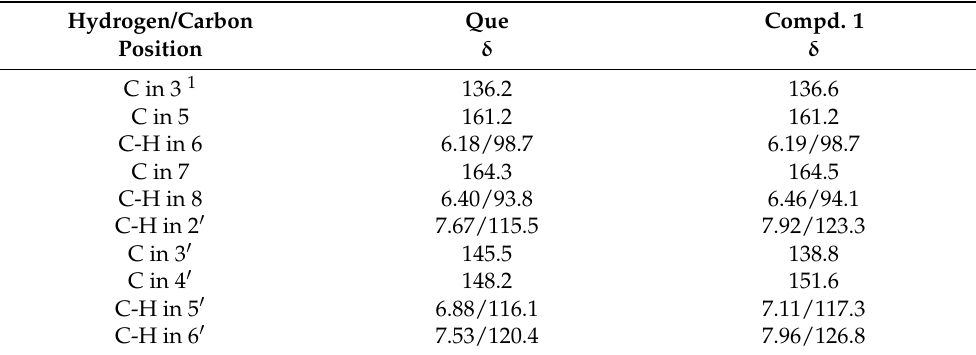
Table 1. 1 H- and 13 C-NMR (600 MHz, DMSO- d 6 ) chemical shifts of the protons and carbons of quer- cetin (Que) and 3′ -ferulic quercetin ester (Compd. 1 ).